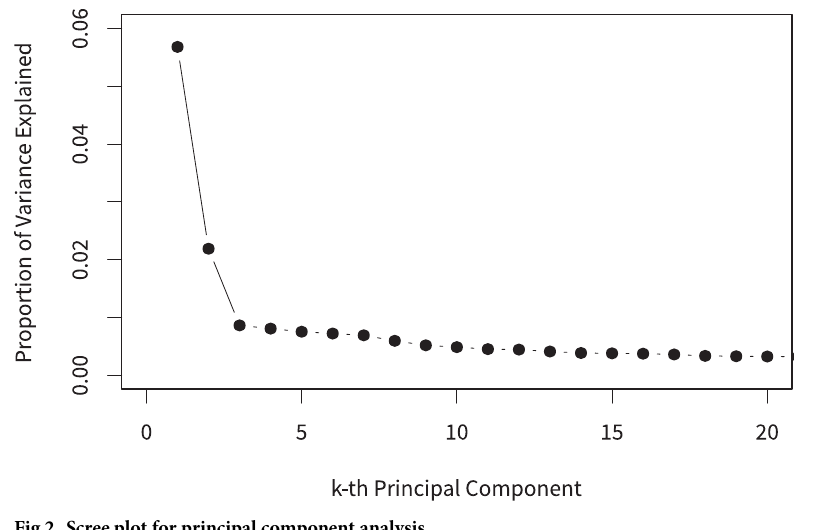
Fig 2. Scree plot for principal component analysis.